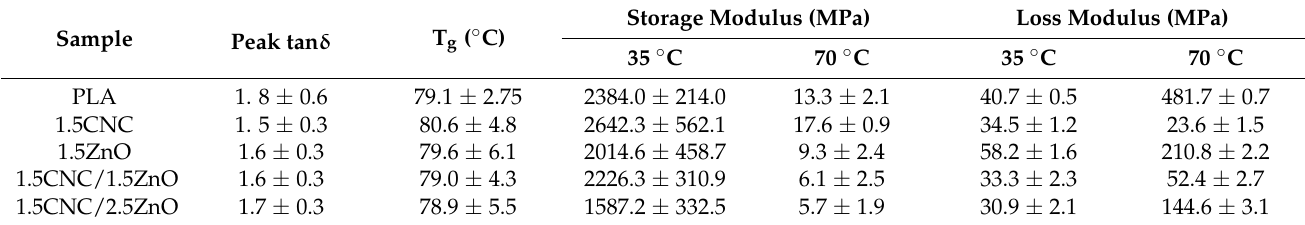
Table 2. Mechanical properties of each formulation from dynamic mechanical analysis